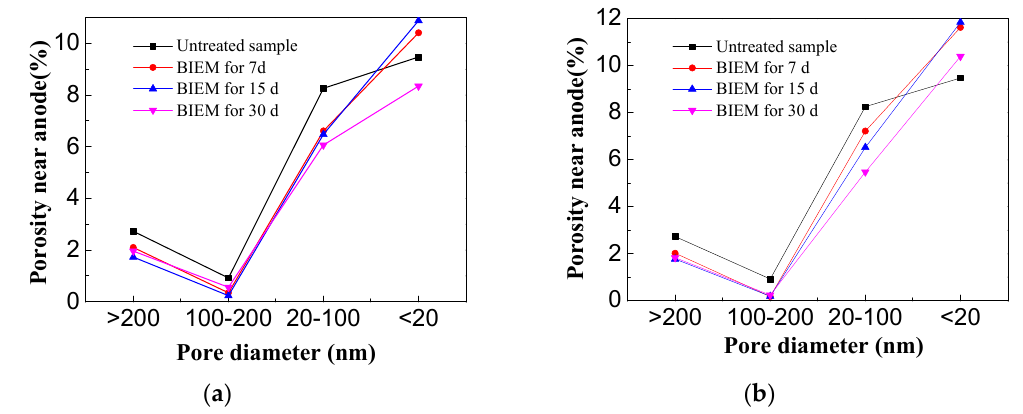
Figure 17. Porosity distribution of concrete cover after Bidirectional electromigration rehabilitation ( a ) Anode side; ( b ) Cathode side.